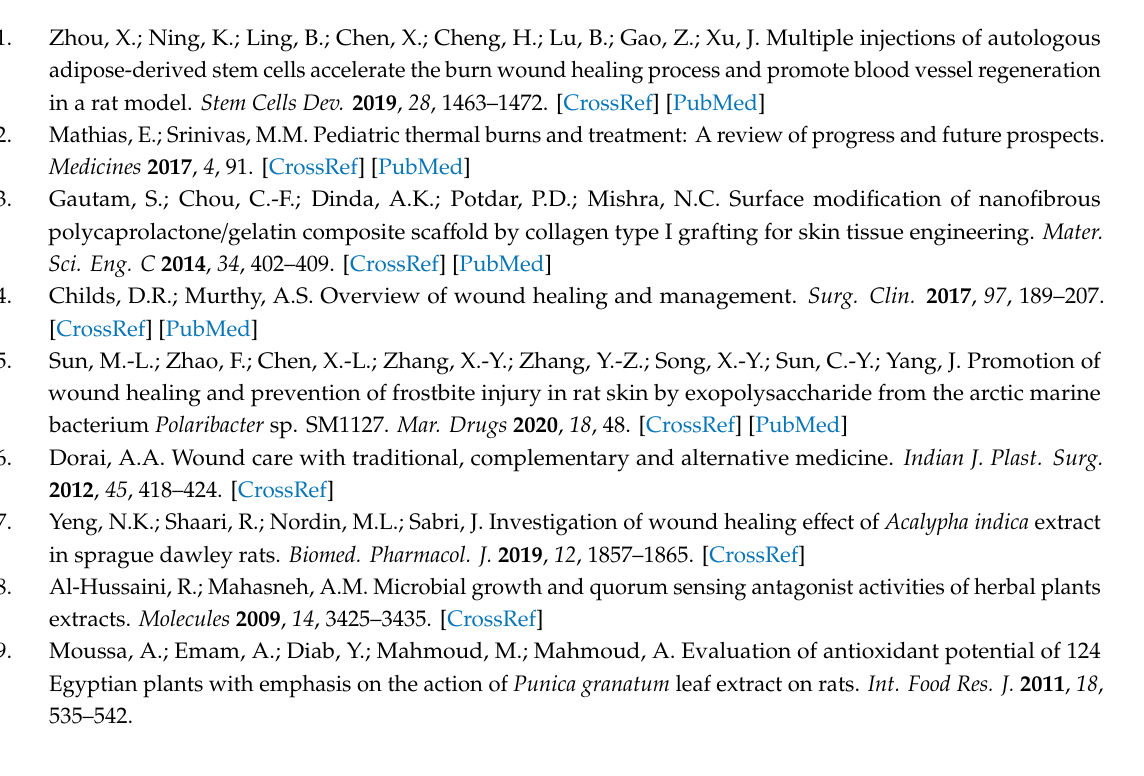
Supplementary Materials: The following are available online, Figure S1: Figure S1. Macroscopic incision wound measurements of a skin section from (A) control positive group, (B) drug treated group (C) para ffi n treated group, (D) 10% myricetin treated group, (E) 20% myricetin treated